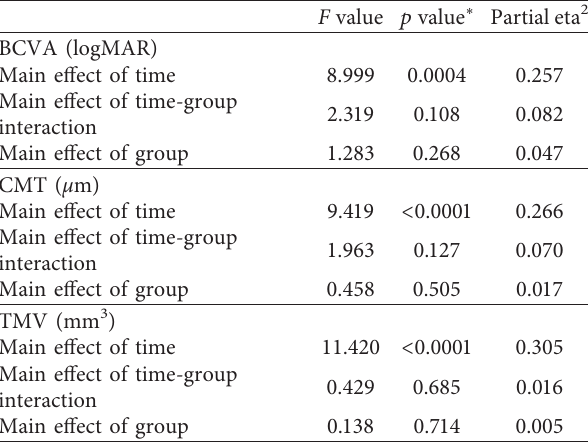
Table 5: Comparison of the effect of intravitreal ranibizumab on BCVA, CMT, and TMV values in nonvitrectomized and vitrec- tomized